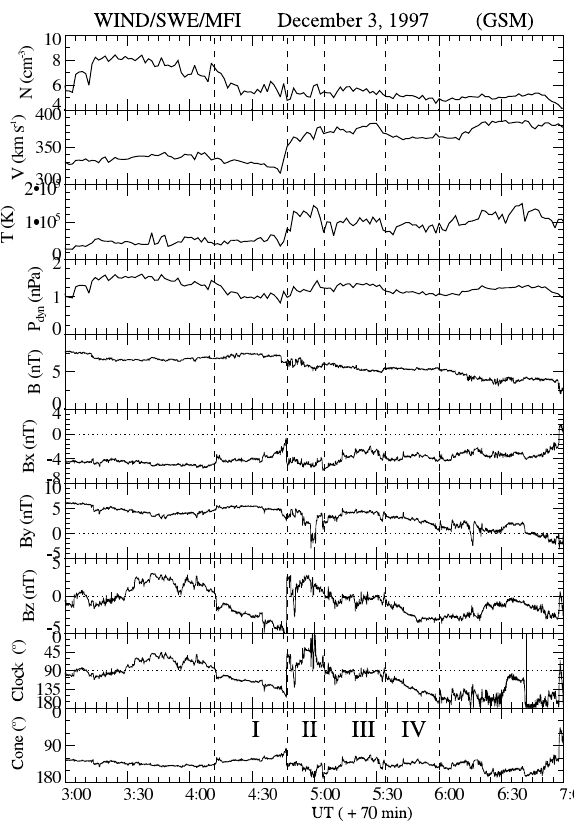
Fig. 1. Interplanetary conditions as observed by Wind on 3 De- cember 1997. The UT reflects the estimated 70-min lag from Wind to the magnetopause. Top to bottom: Solar wind density, velocity, temperature, and dynamic pressure; total interplanetary magnetic field, its GSM components, clock angle (azimuth in YZ GSM plane), and cone angle (angle from X GSM direction).